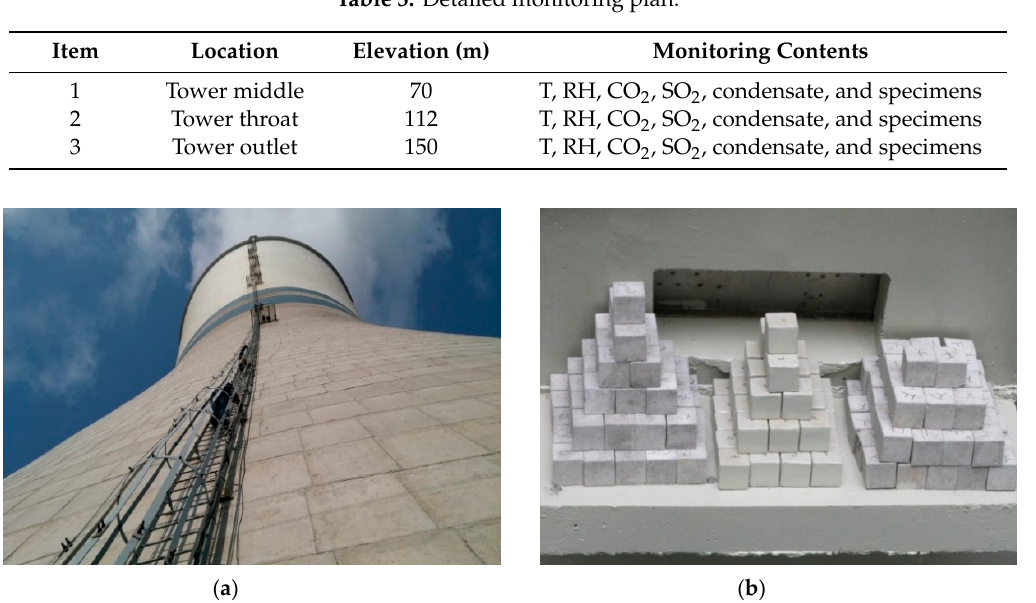
Table 3. Detailed monitoring plan.